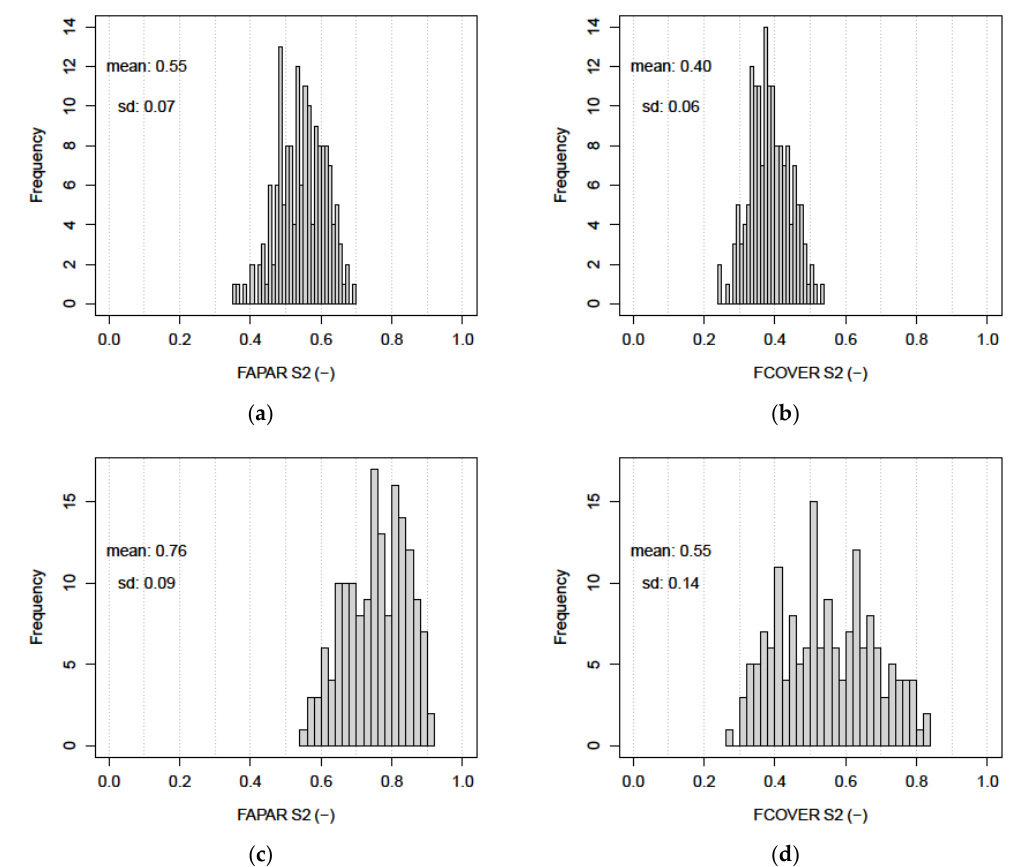
Figure 5. Value distributions of FAPAR-S2 and FCOVER-S2 across the study site in the spring ( a , b ) and summer ( c , d ).